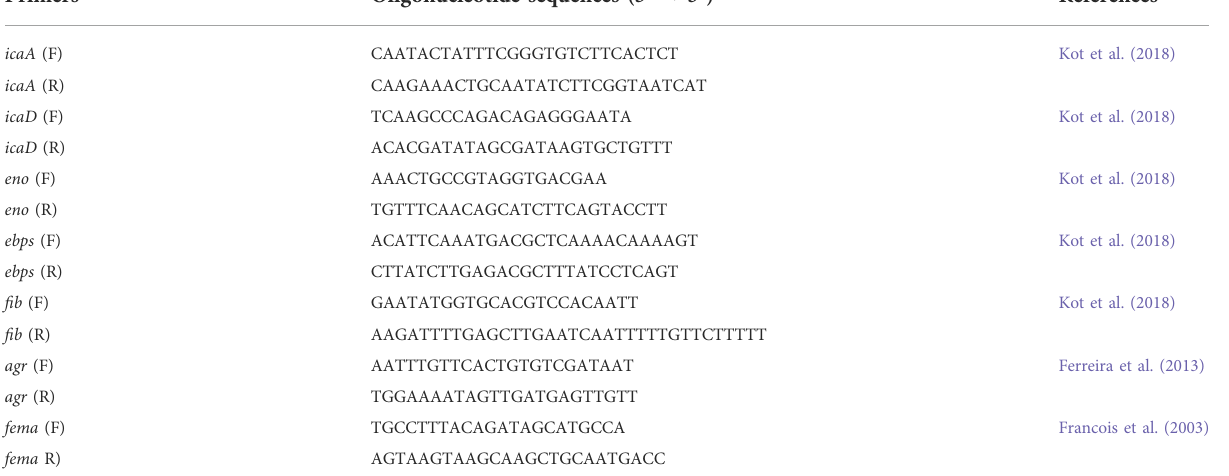
TABLE 1 Primers used for